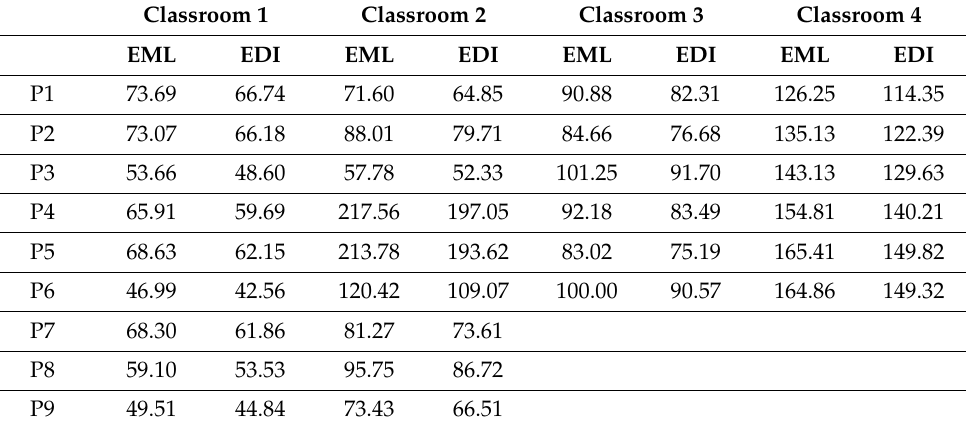
Table 5. Melanopic illumination (m-lux) in the corneal plane, only artificial light (vertical at 130 cm 0 ◦ :